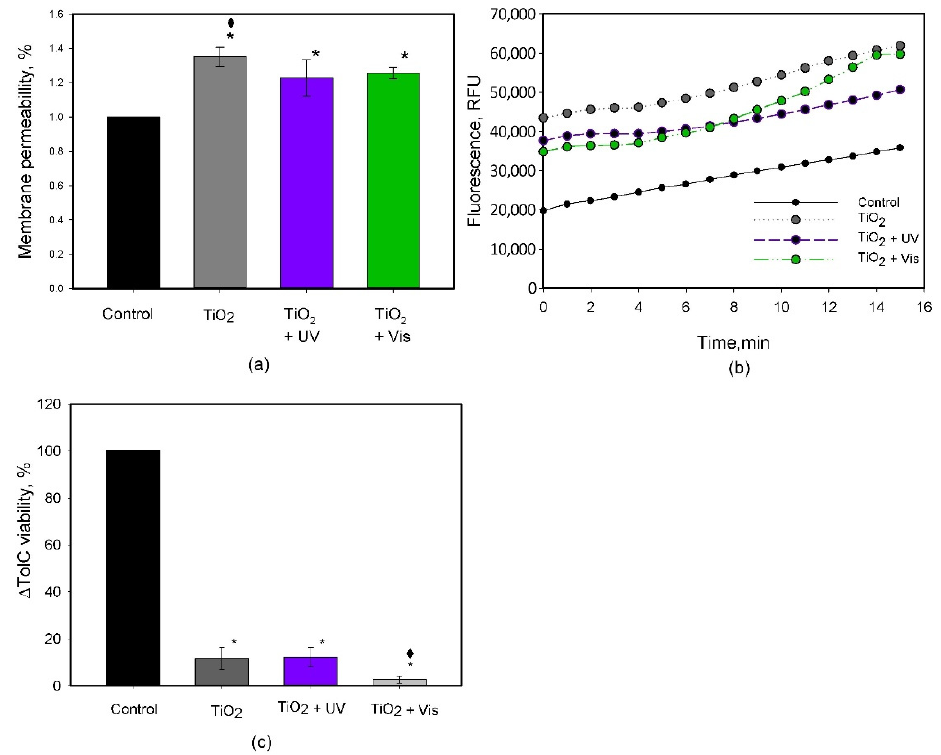
Figure 6. Effects of light and TiO 2 on S. Typhimurium ∆ TolC cells: ( a ) outer membrane permeability; ( b ) intracellular ROS concentration and ( c ) viability of S. Typhimurium ∆ TolC mutant cells. The experiments were performed in PBS buffer, pH 7.4, containing 0.1% glucose. Concentrations of the cells and TiO 2 were 3 × 10 7 cfu/mL and 0.3 mg/m, respectively. * and ♦ mark experimental values which are significantly different from the control sample and other samples respectively (more details on statistical analysis are provided in Section 4.5).